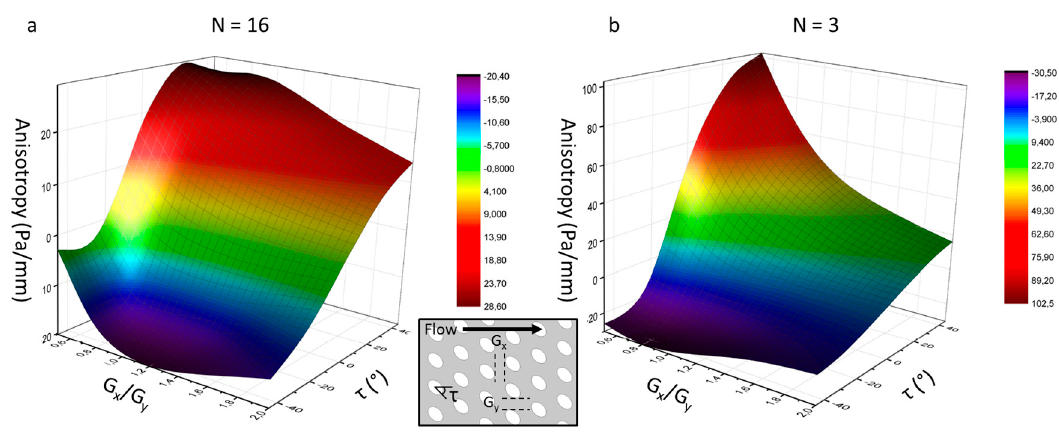
Figure 3. Evolution of the anisotropy with the ratio of lateral-gap to downstream-gap (G x /G y ) and the pillar slant angle ( τ ) for an array period N = 16 ( a ) and N = 3 ( b